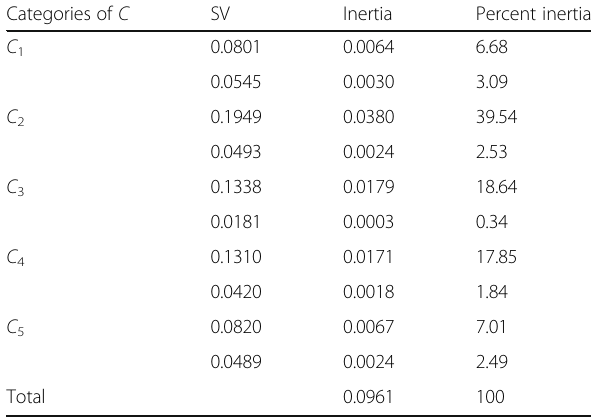
Table 7 Results of MCA for Table 6 along B and A across